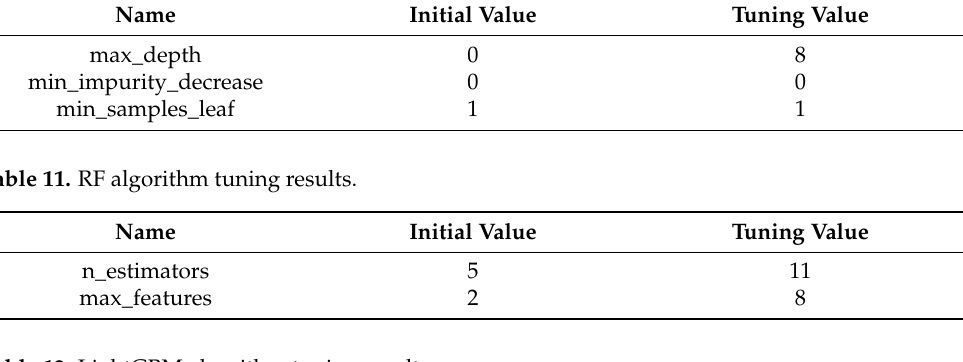
Table 12. LightGBM algorithm tuning